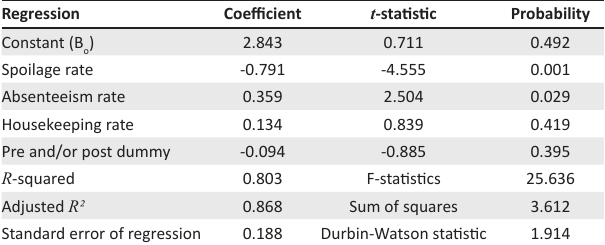
TABLE 4: Results for labour productivity as a dependent variable to absenteeism, spoilage, housekeeping, as well as post-shop floor management dummy. Regression